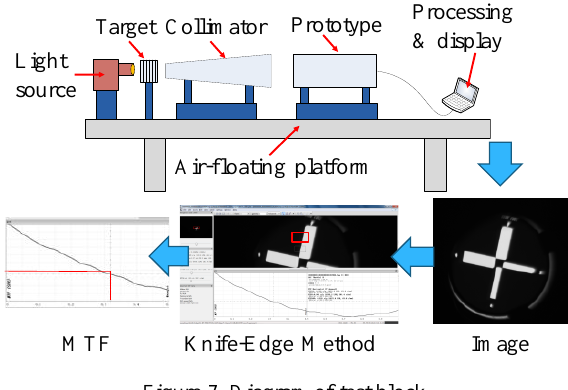
Figure 7. Diagram of test block